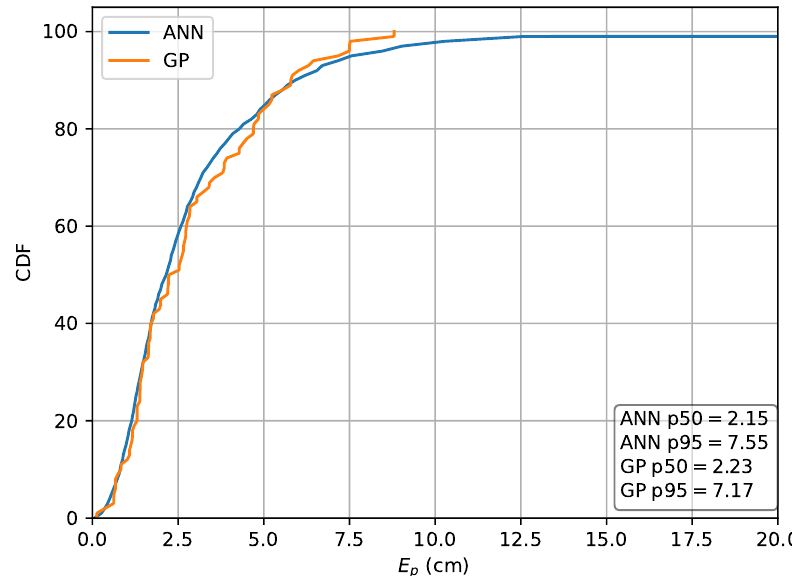
Figure 12. Cumulative distribution of the error evaluated on set A for the ML methods in the case the relative intensities r rel , all are used as